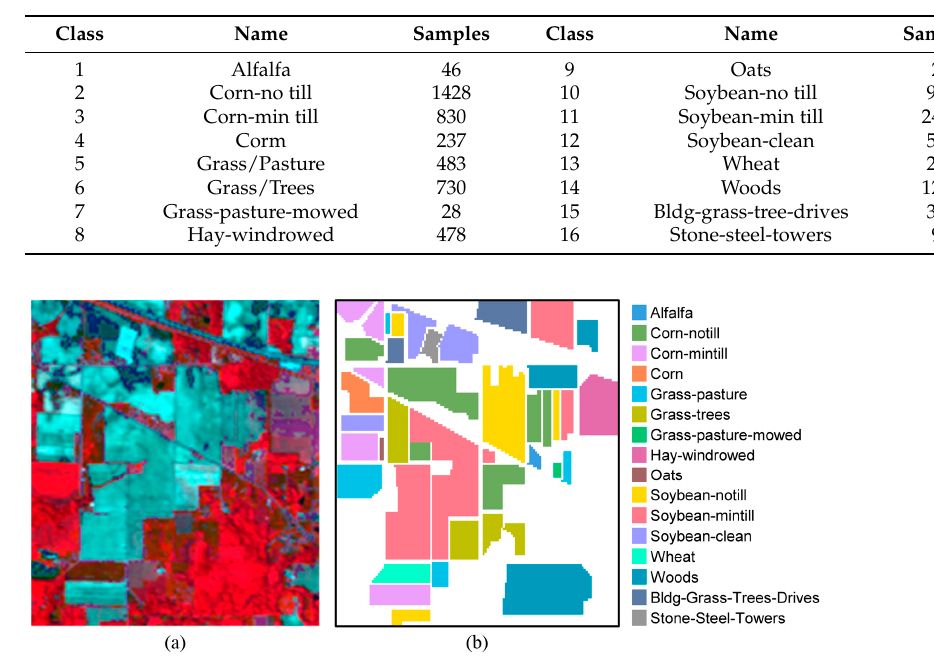
Table 1. Sixteen ground-truth classes of the Indian Pines data set.